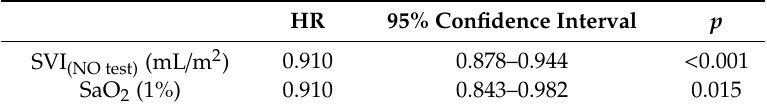
Table 8. Multivariable Cox regression analysis with step wise algorithm ( p < 0.2)